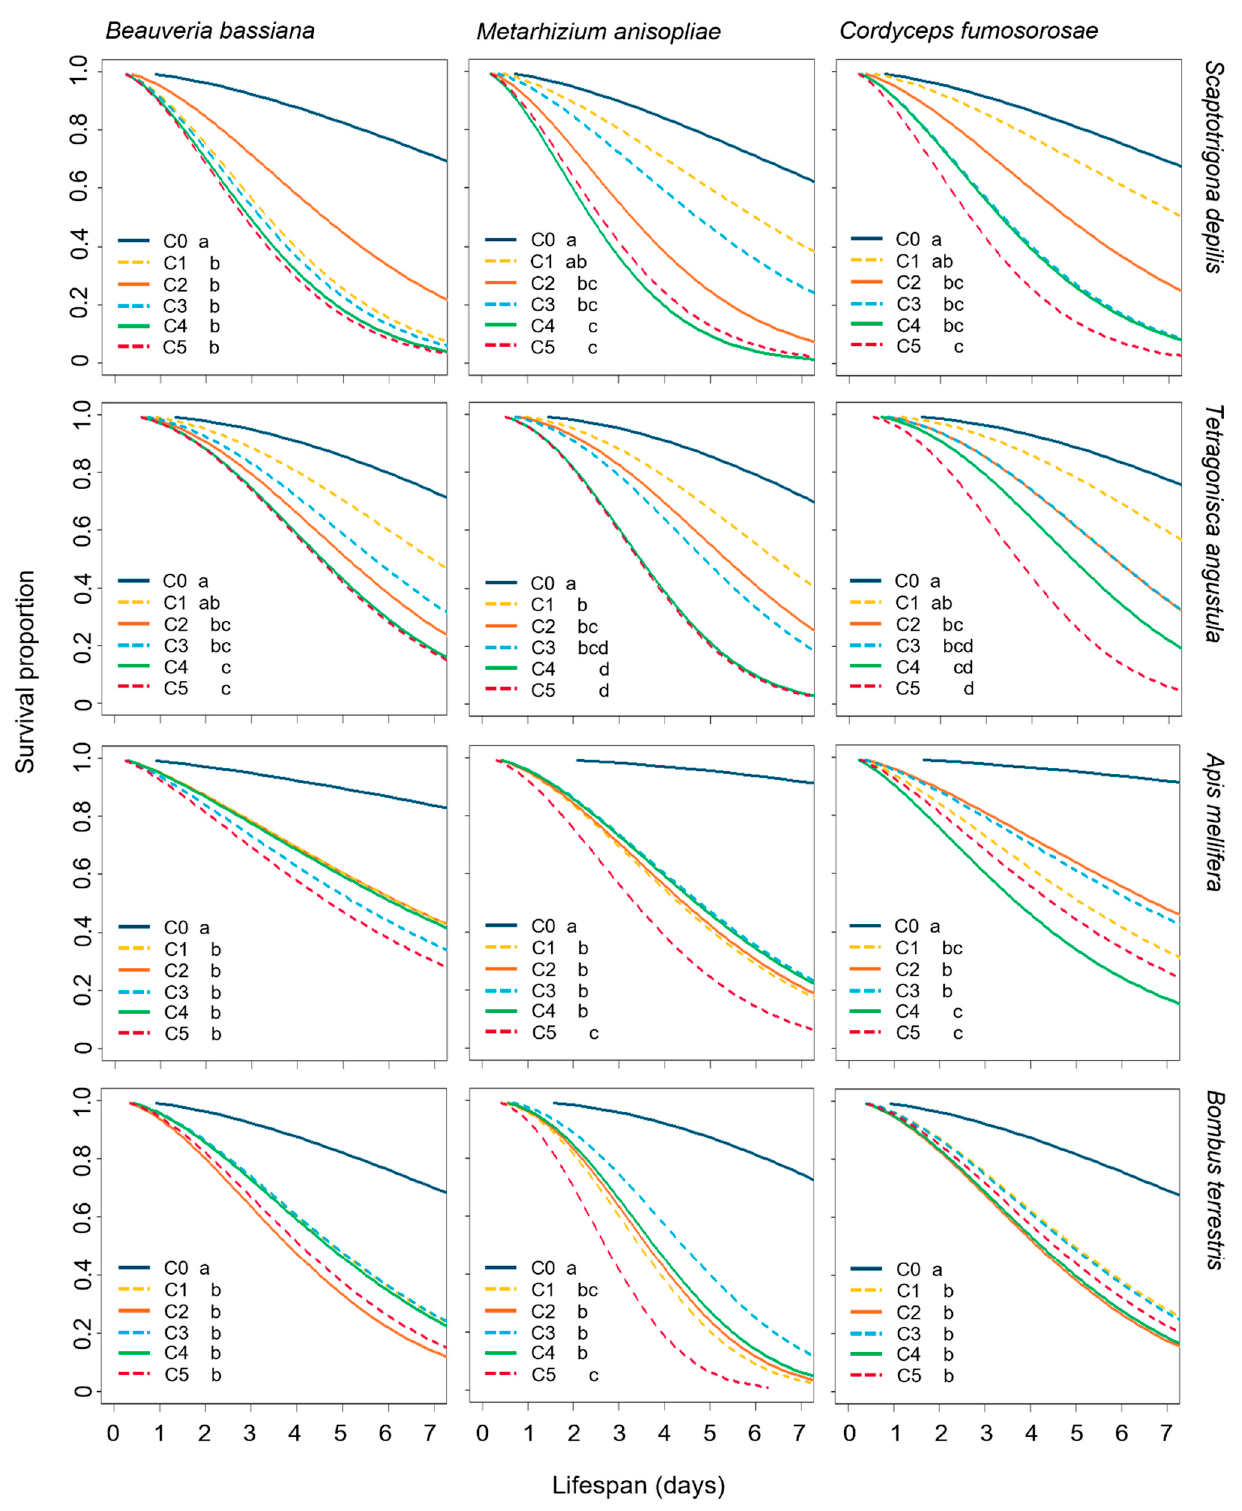
Figure 2. Survival proportion of Scaptotrigona depilis ( n = 150 workers), Tetragonisca angustula ( n = 240 workers), Apis mellifera ( n = 300 workers) and Bombus terrestris ( n = 150 workers) to oral exposure of three entomopathogenic fungi, Beauveria bassiana , Metarhizium anisopliae and Cordyceps fumosorosea . Concentrations: control (C0), 5 × 10 5 conidia mL − 1 (C1), 1 × 10 6 conidia mL − 1 (C2), 5 × 10 6 conidia mL − 1 (C3), 1 × 10 7 conidia mL − 1 (C4), 5 × 10 7 conidia/mL − 1 (C5). Concentrations with different letters are significantly different ( p < 0.05).